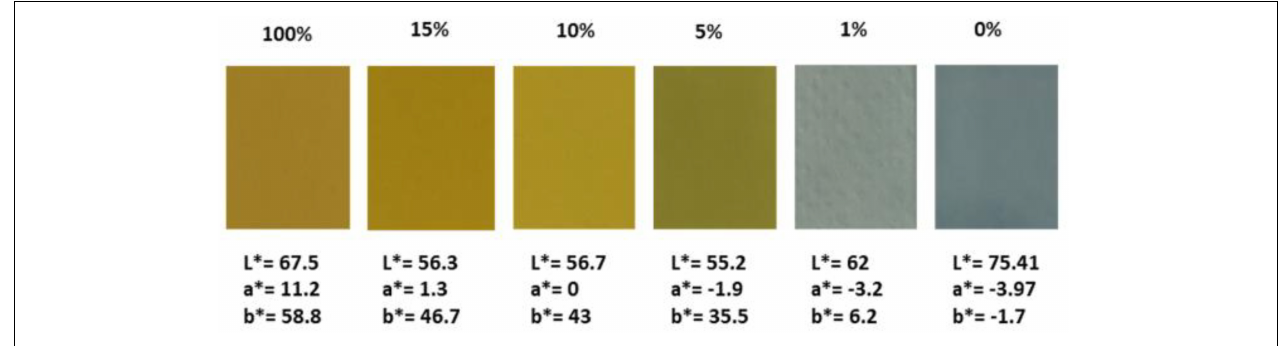
FIGURE 1 | As-deposited hybrid films wt% PEDOT:PSS-V 2 O 5 using the bar n = 3 with the corresponding L*, a*, b* chromaticity parameters.